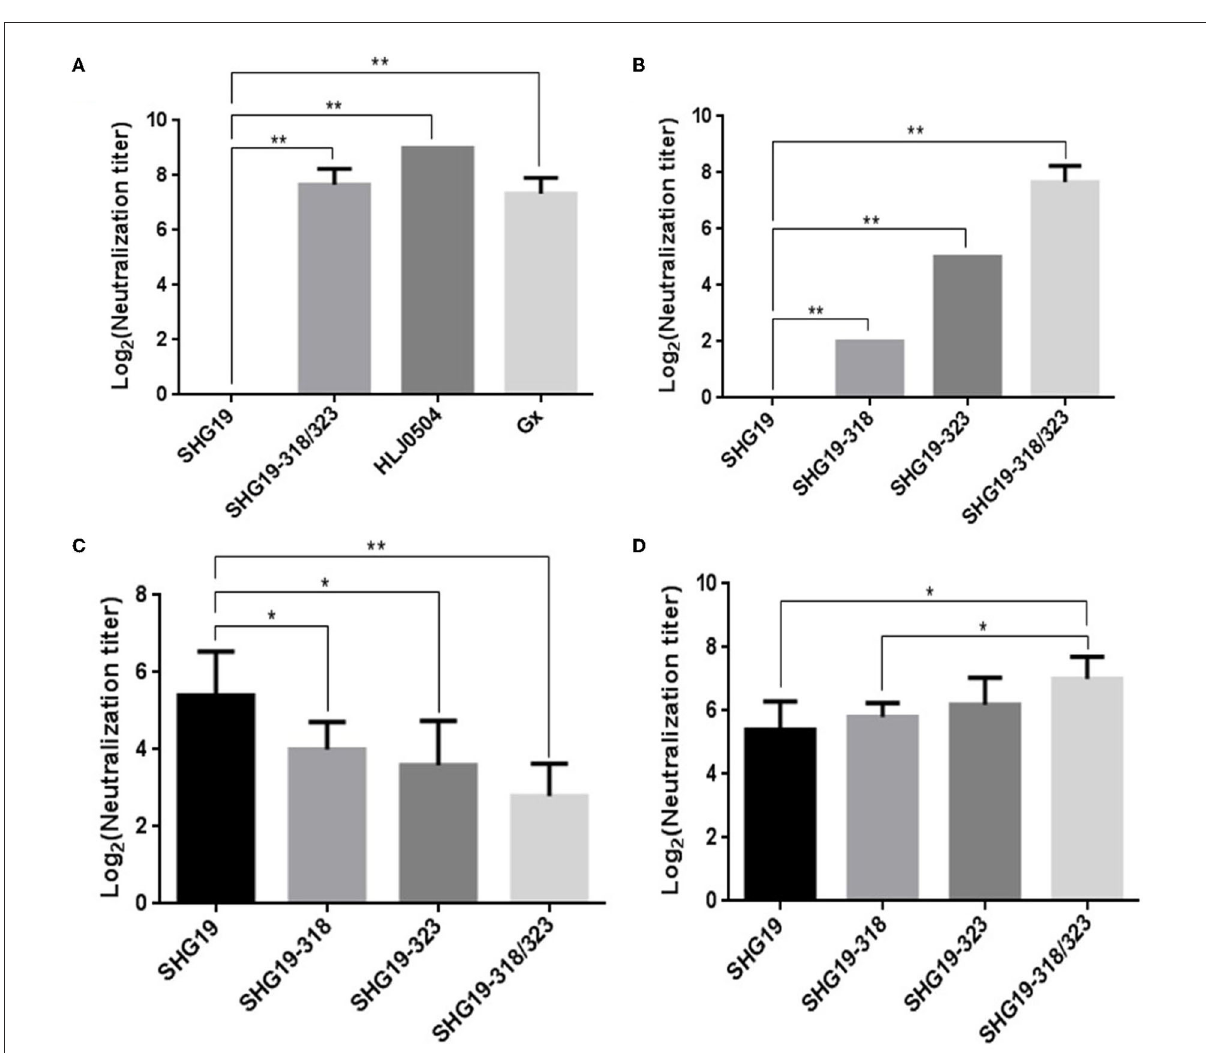
FIGURE6 Cross-neutralizing assay. (A) Cross-neutralizing assay directed by the MAb 2-5C-6F for the epizootic varIBDV (SHG19 strain), vvIBDV (HLJ0504 strain and Gx strain), and double-mutated virus (SHG19-318/323). (B) Cross-neutralizing assay directed by the MAb 2-5C-6F for the SHG19 strain and its mutants (SHG19-318, SHG19-323, and SHG19-318/323). (C) Cross-neutralizing assay directed by SHG19 antiserum for the SHG19 strain and its mutants. (D) Cross-neutralizing assay directed by SHG19-318/323 antiserum for the SHG19 strain and its mutants. The mean titers and standard deviations (error bars) from three (A,B) or five (C,D) independent samples are shown. * and ** represent P < 0.05 and P <